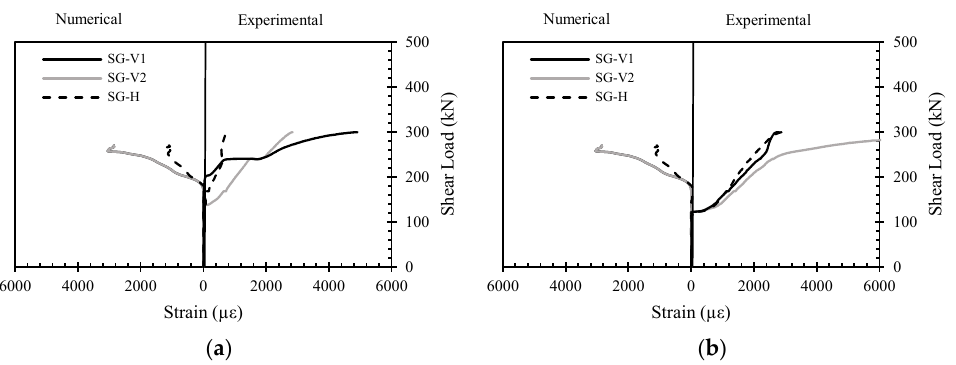
Figure 11. Numerical and experimental stirrup strain response of SR100-SF0-S: ( a ) west shear span; ( b ) east shear span.